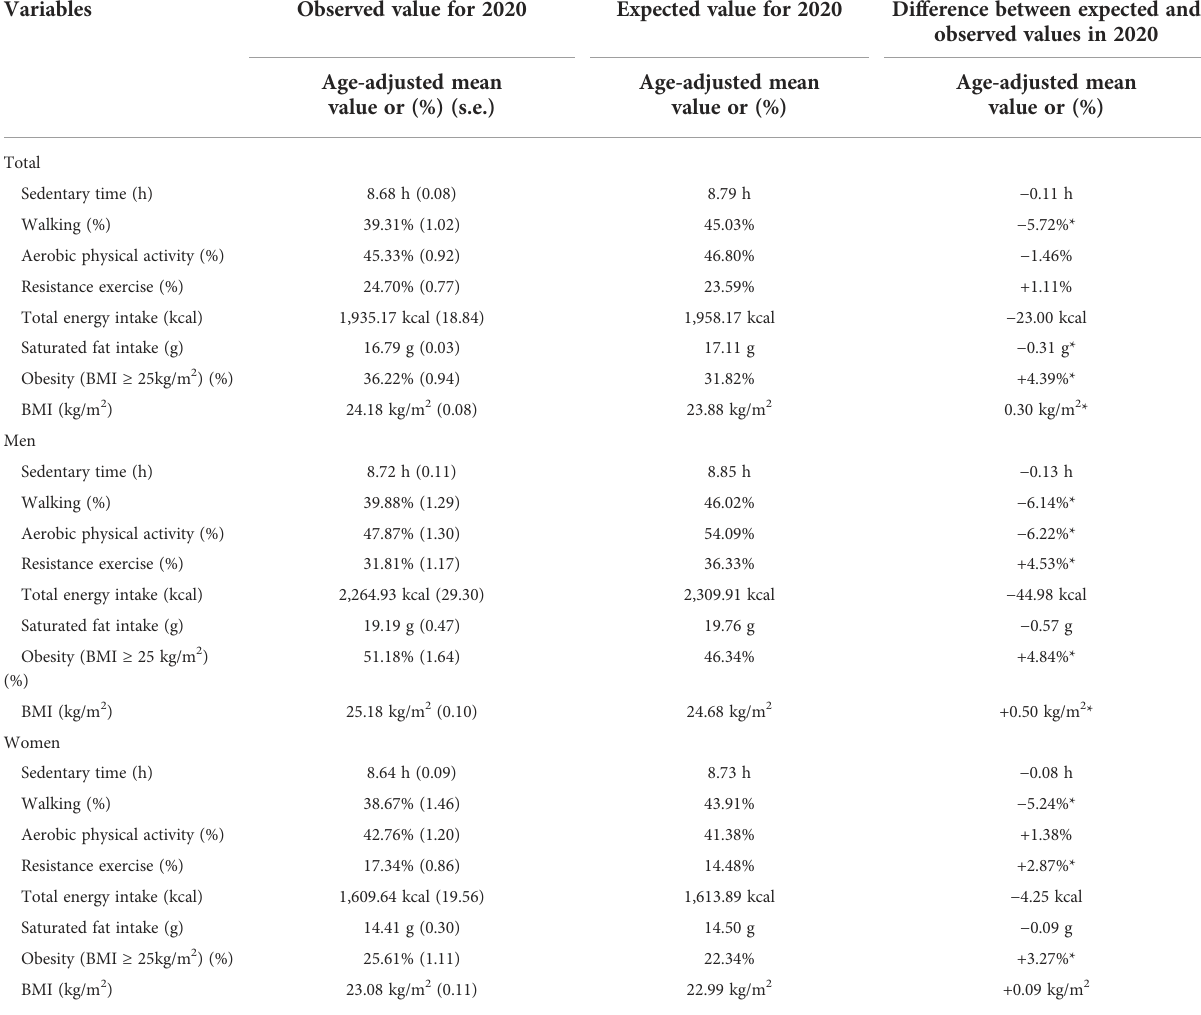
TABLE 1 Age-adjusted difference between expected and observed values for physical activity, nutrient intake, and obesity in